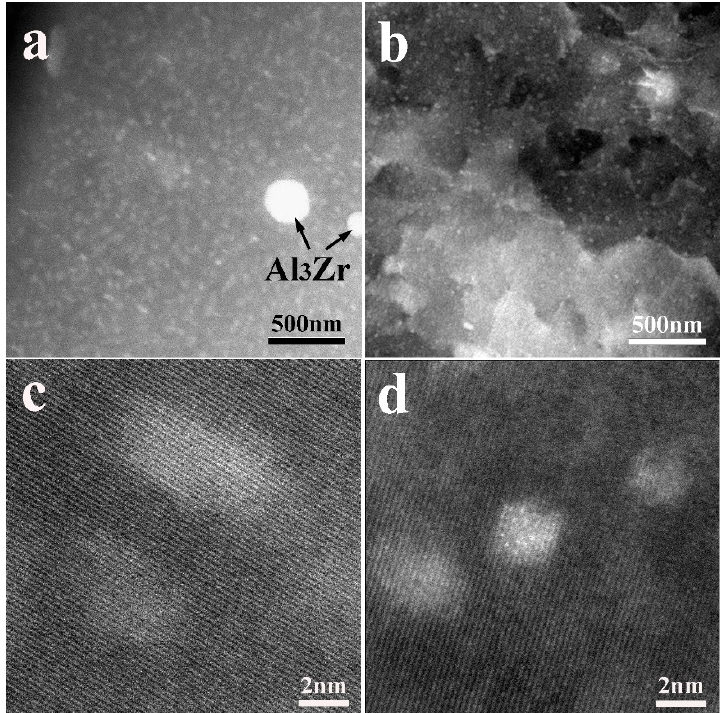
Figure 5. HAADF-STEM images showing precipitates in the T6-treated sample ( a , c ) and AR sample ( b , d ). Images were obtained under conditions with Z contrast using HAADF detector, along <112> Al zone axis.